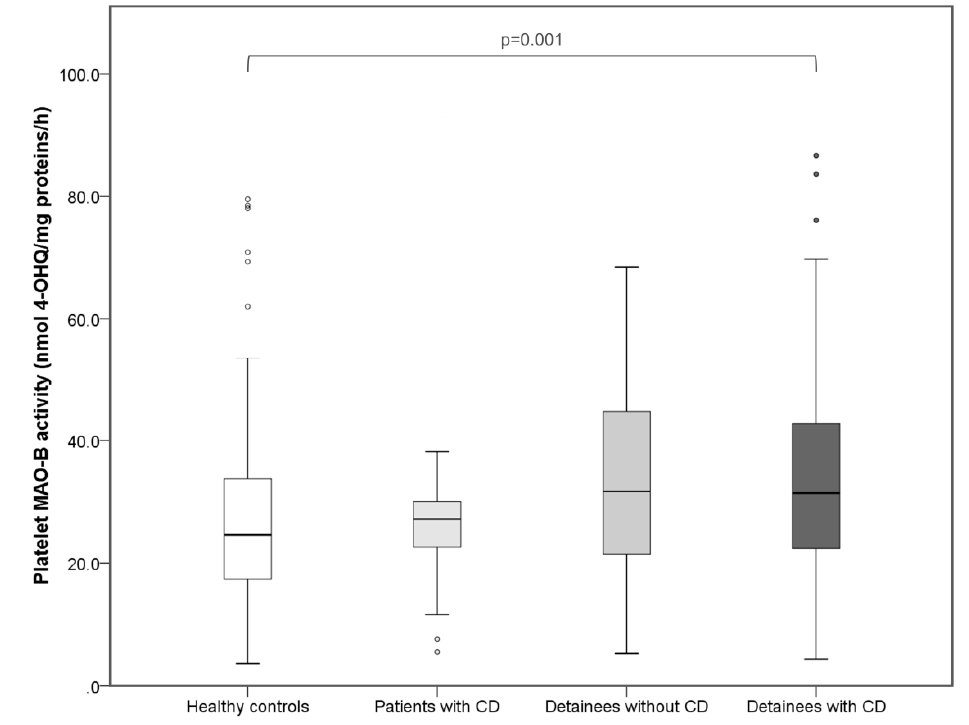
Figure 1. Platelet MAO-B activity in subjects detained in a juvenile correctional facility, with ( N = 117) and without ( N = 65) diagnosis of CD, 26 outpatients with CD, and 81 mentally healthy controls. Results are presented as a box and whisker plot. The median is represented by the line in the box, while the interquartile range (IQR) box represents the middle quartiles (the 75th minus the 25th percentile). The whiskers on either side of the IQR box represent the lowest and highest quartiles of the data. The ends of the whiskers represent the maximum and minimum of the data, while the individual dots beyond the whiskers represent outliers in the data set.